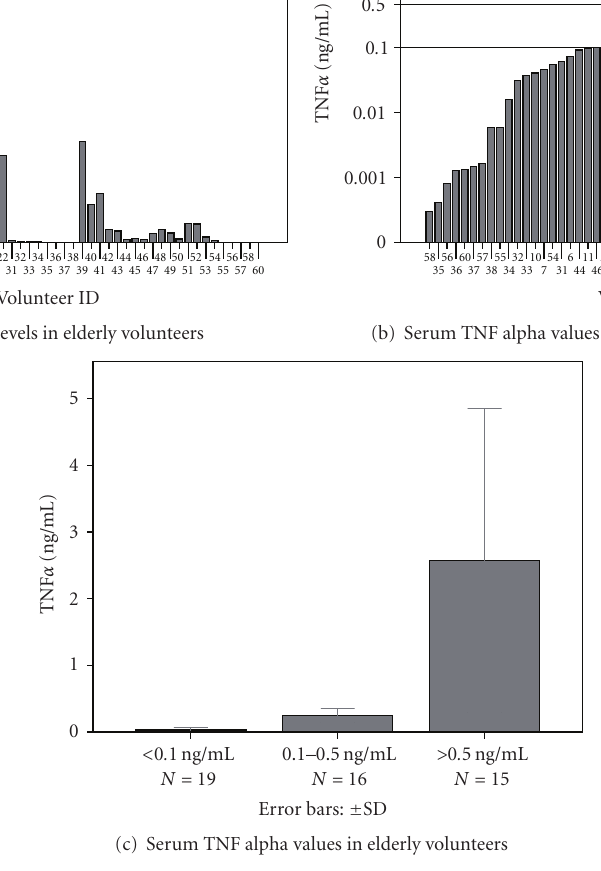
Figure 1: Serum TNF α individual values in elderly volunteers (a) and order of individual values (b) demonstrate three subgroups of the elderly population (c).